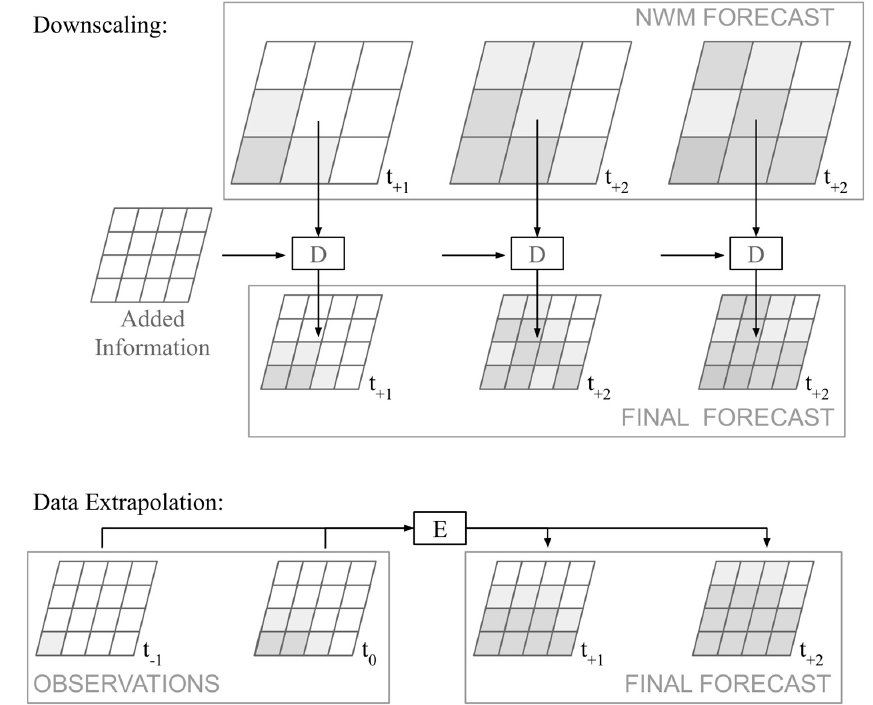
Figure 3. Schematic representation of downscaling (D) and data extrapolation (E) processes to obtain high-resolution precipitation products. The “Added Information” can be either sub-grid physics or statistical relationships.